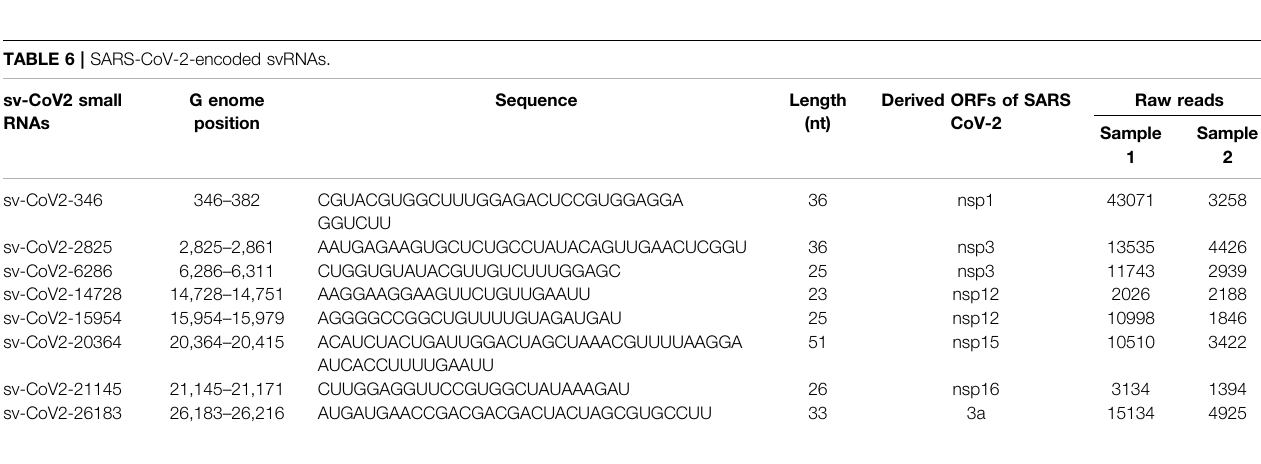
Sequence Length